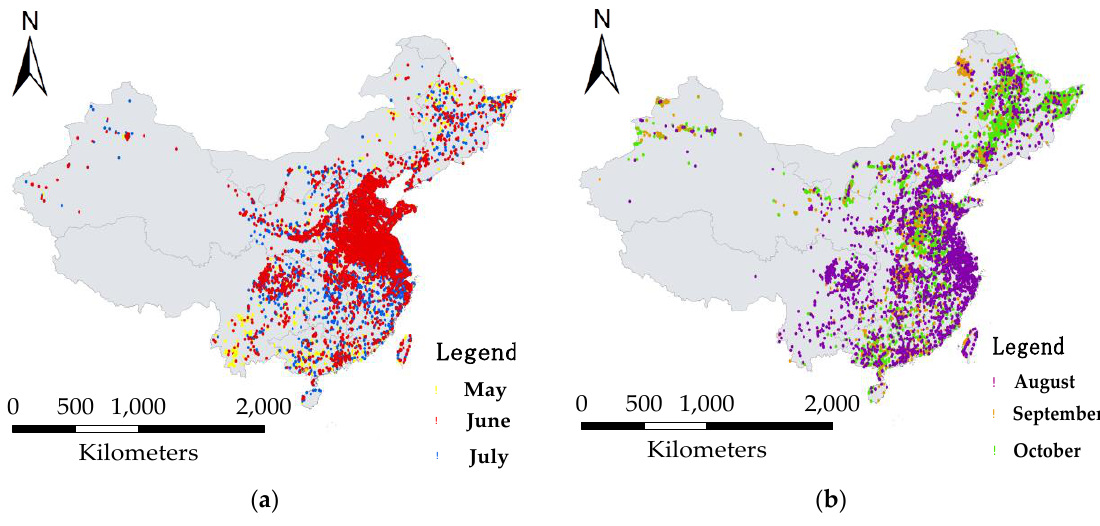
Figure 7. The spatial-temporal distribution of agricultural fires from 2010 to 2014: ( a ) May–July (summer harvest period); ( b ) August–October (autumn harvest period).